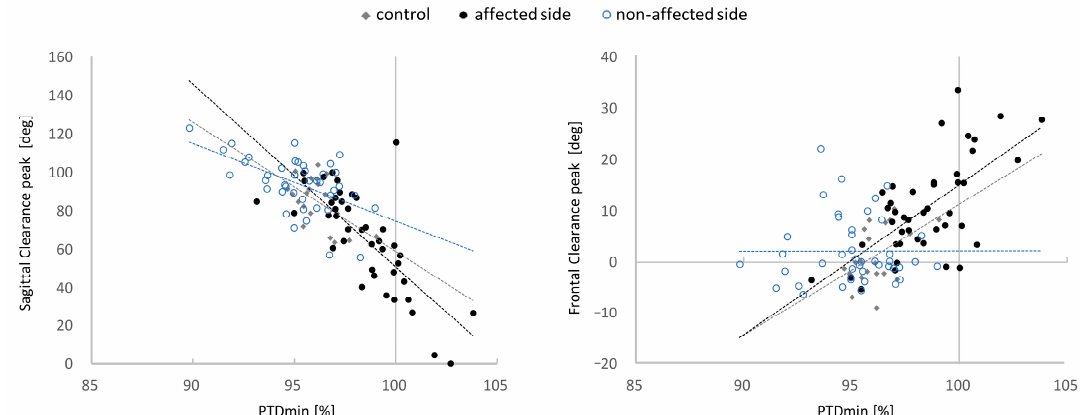
Figure 3. Correlations of PTDmin with the SC peak ( left ) and the FC peak ( right ). Dashed lines represent the trend line for each group (black is the affected side, blue is the non-affected side, and grey is the control).